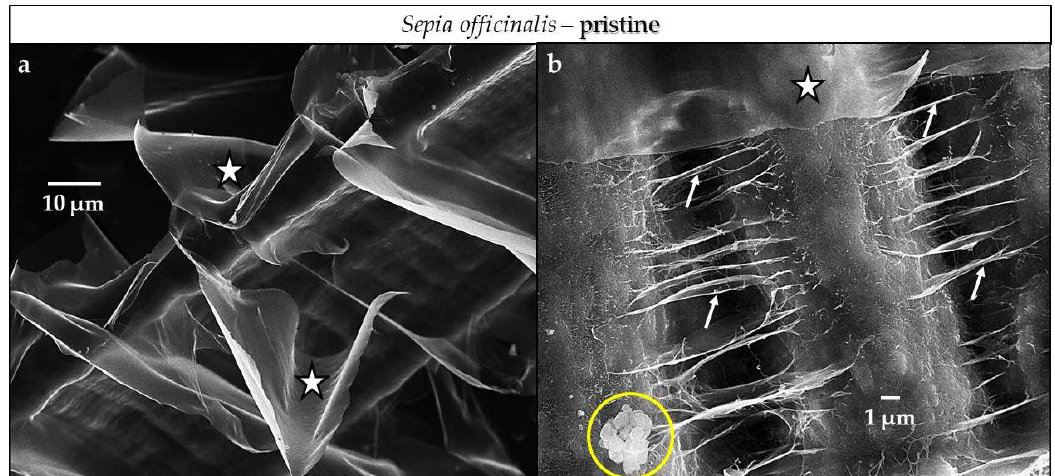
Figure A13. FE-SEM images of biopolymers occluded within the cuttlebone of pristine Sepia officinalis . Thick membranes line the walls and platforms (white stars in ( a , b )). A network of biopolymer films is occluded within the major structural elements of the cuttlebone, e.g., in a wall ( b ). An accumulation of aragonite nanoparticles constituting the skeleton appear encircled in ( b ).